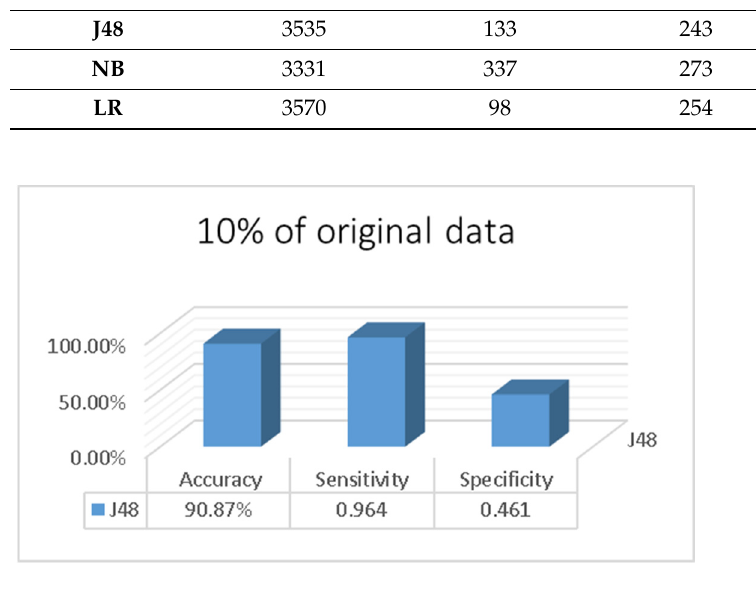
Table 2. Confusion matrix for the three trained models.